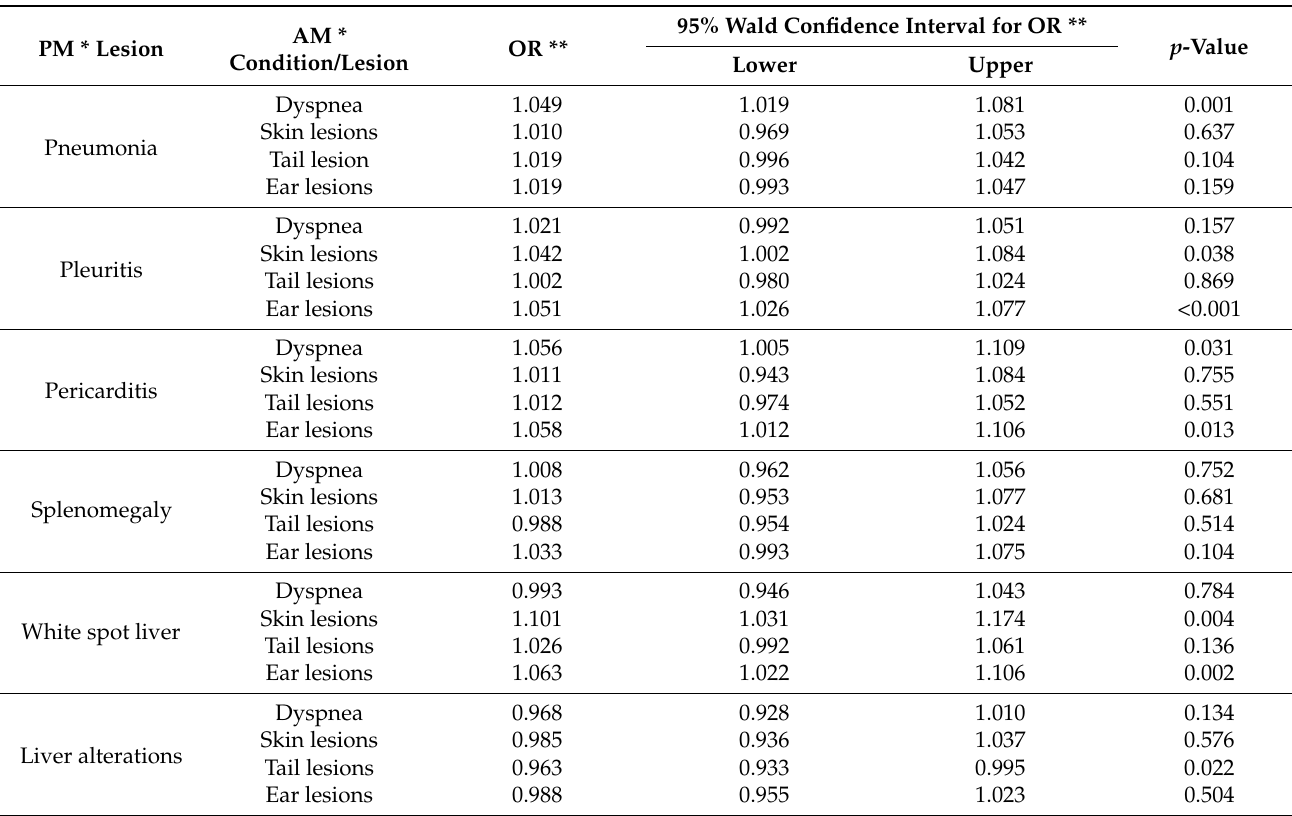
Table 4. Relationship between the counts of post-mortem and ante-mortem relief observed in slaugh- tered pig batches ( N = 35). Poisson regressions were used to analyze the data. Univariable models were built, where each PM was included as a dependent variable and each AM was an independent variable. Only AM conditions with a prevalence >5% and PM with a mean prevalence >3% were examined. For all the models, batch size was included as an offset